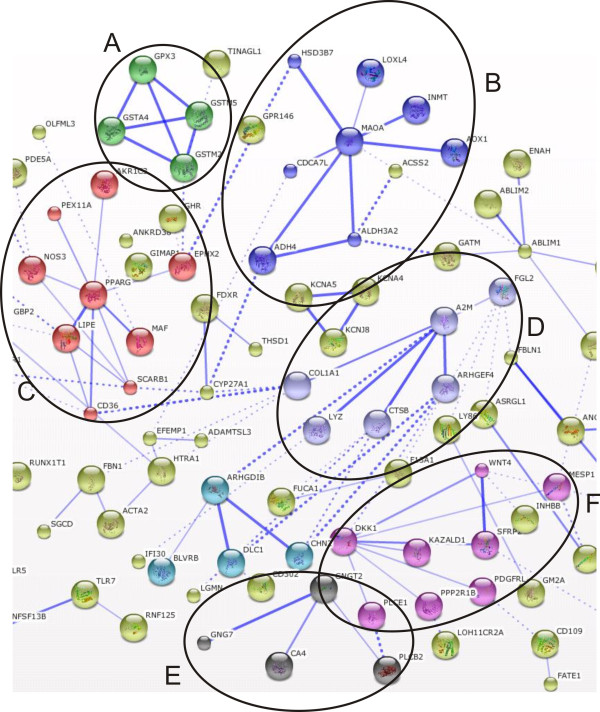
The gene functional clusters identified for the significant, downregulated adipose tissue transcriptome. The downregulated adipose tissue network(n = 7) had 6 functional clusters: (A) cellular defense against toxic compounds; (B) redox reactions; (C) PPARγ signaling; (D) innate immune system; (E) G-receptor signaling; (F) Wnt-signaling.